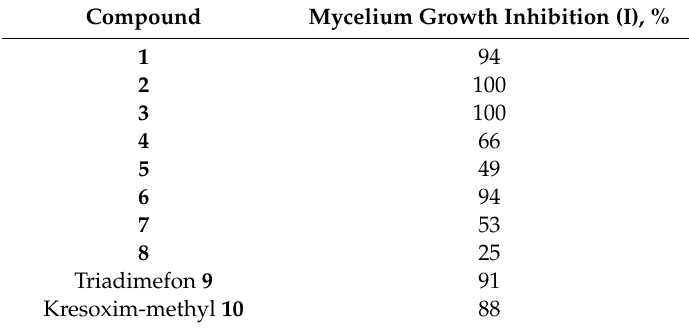
Table 1. Mycelium growth inhibition (I, %) of A. apis by peroxides 1 – 8 , Triadimefon 9 , and Kresoxim-methyl 10 at a concentration of 30 mg / L.